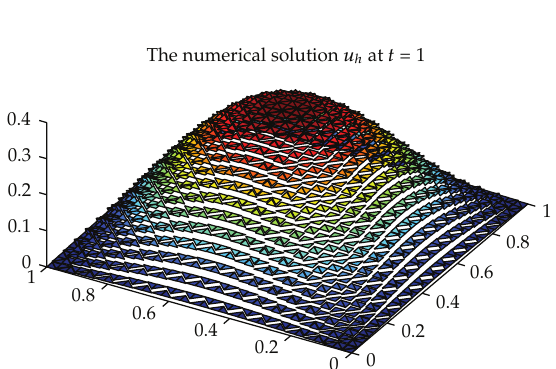
Figure 1: The exact solution u .